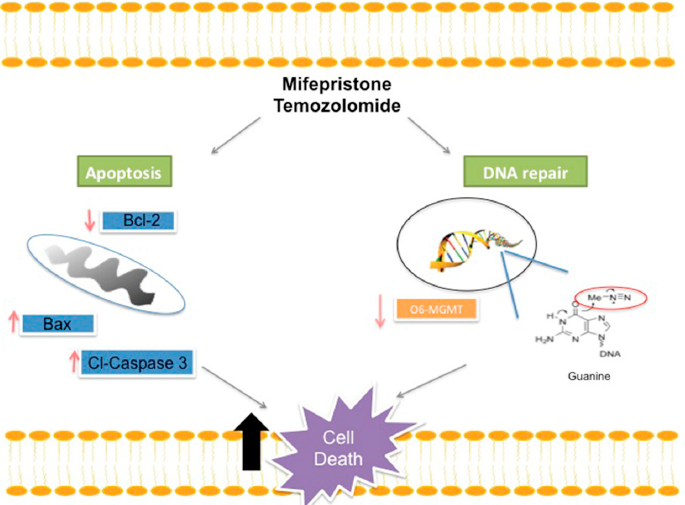
Figure 6. Schematic portrayal of the possible mechanisms of treatment with